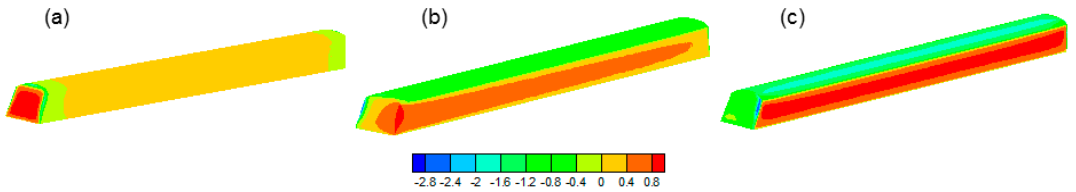
Figure 7. Wind pressure distribution coefficients of the rail train at angles of attack ( a ) 0°, ( b ) 45°, ( c ) 90° calculated with realizable k– ε turbulence model.